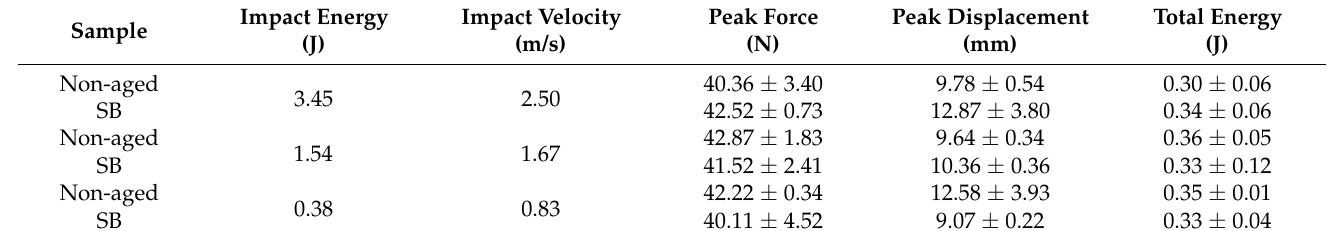
Table 7. Average values and standard deviations for the three impact energies, for PFA non-aged and aged films.